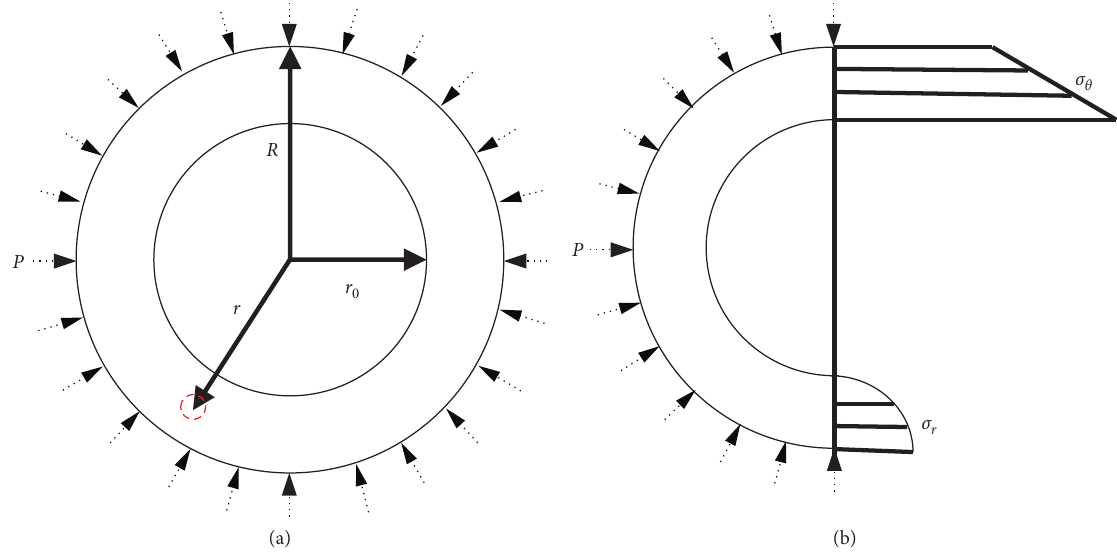
Figure 3: The stress distribution of the thick-walled cylinder under confining